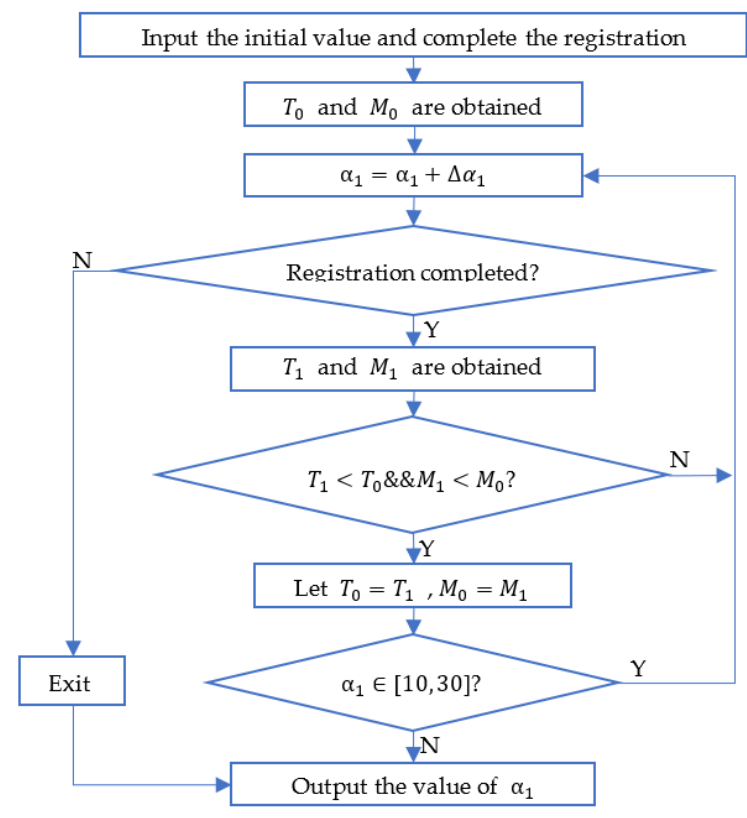
Figure 5. Flowchart of how to obtain the threshold value α 1